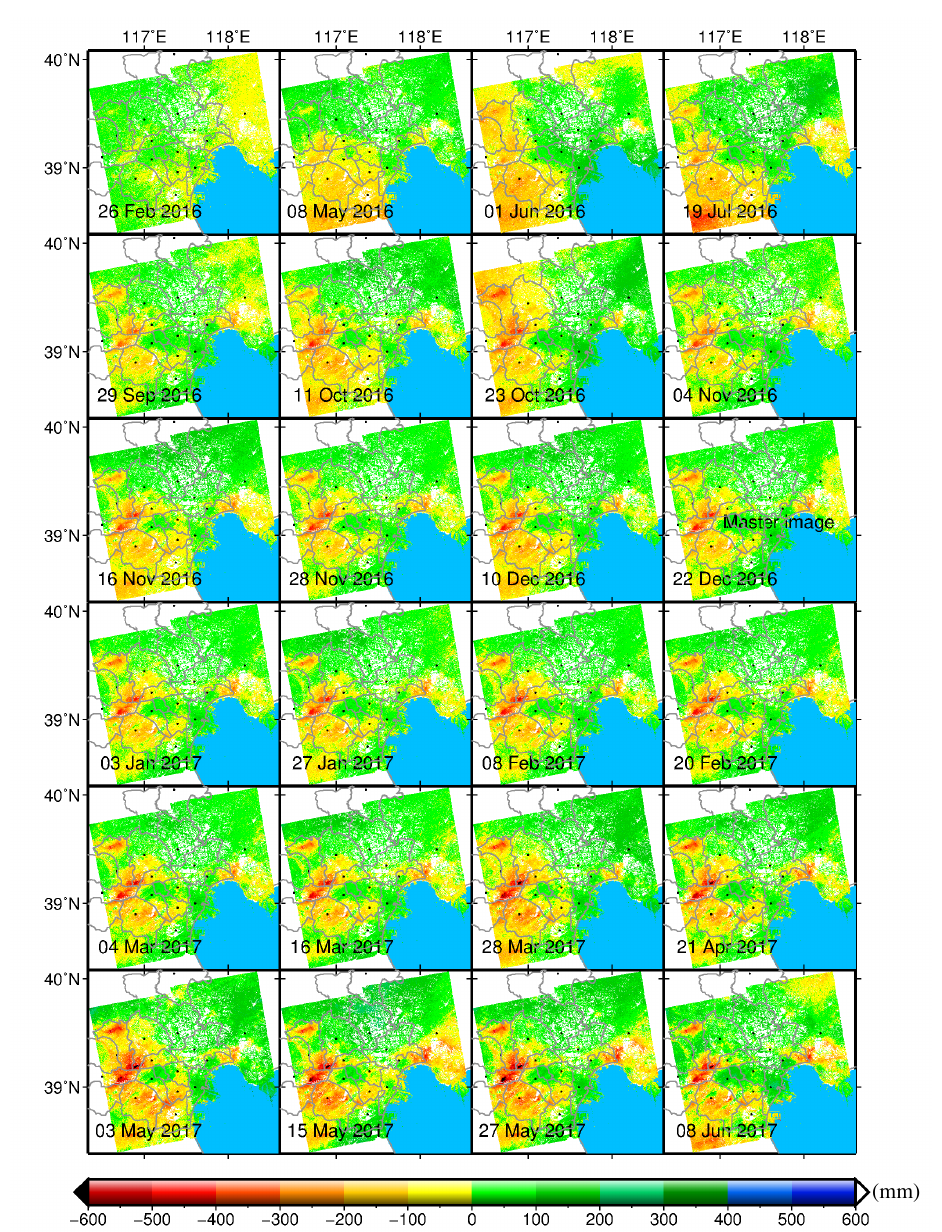
Figure 11. Time series of the vertical deformation for Tianjin from 26 February 2016 to 8 June 2017 referenced temporally to the earliest image (9 January 2016) and referenced spatially to a stable CORS station (JIXN) located in the north-east corner of